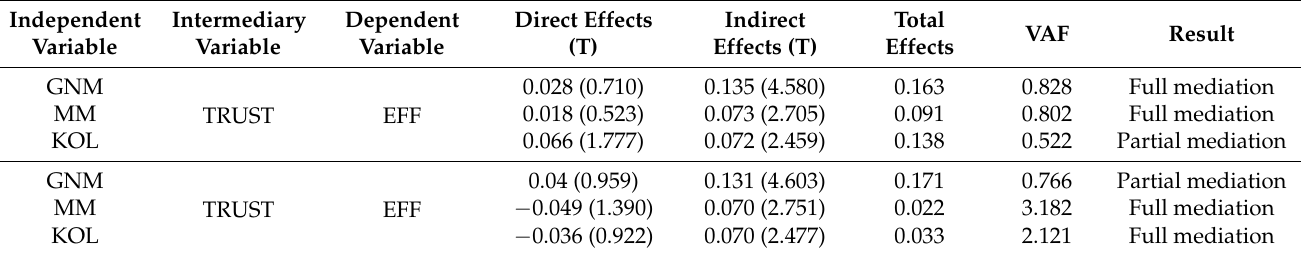
Table 6. Results of mediation